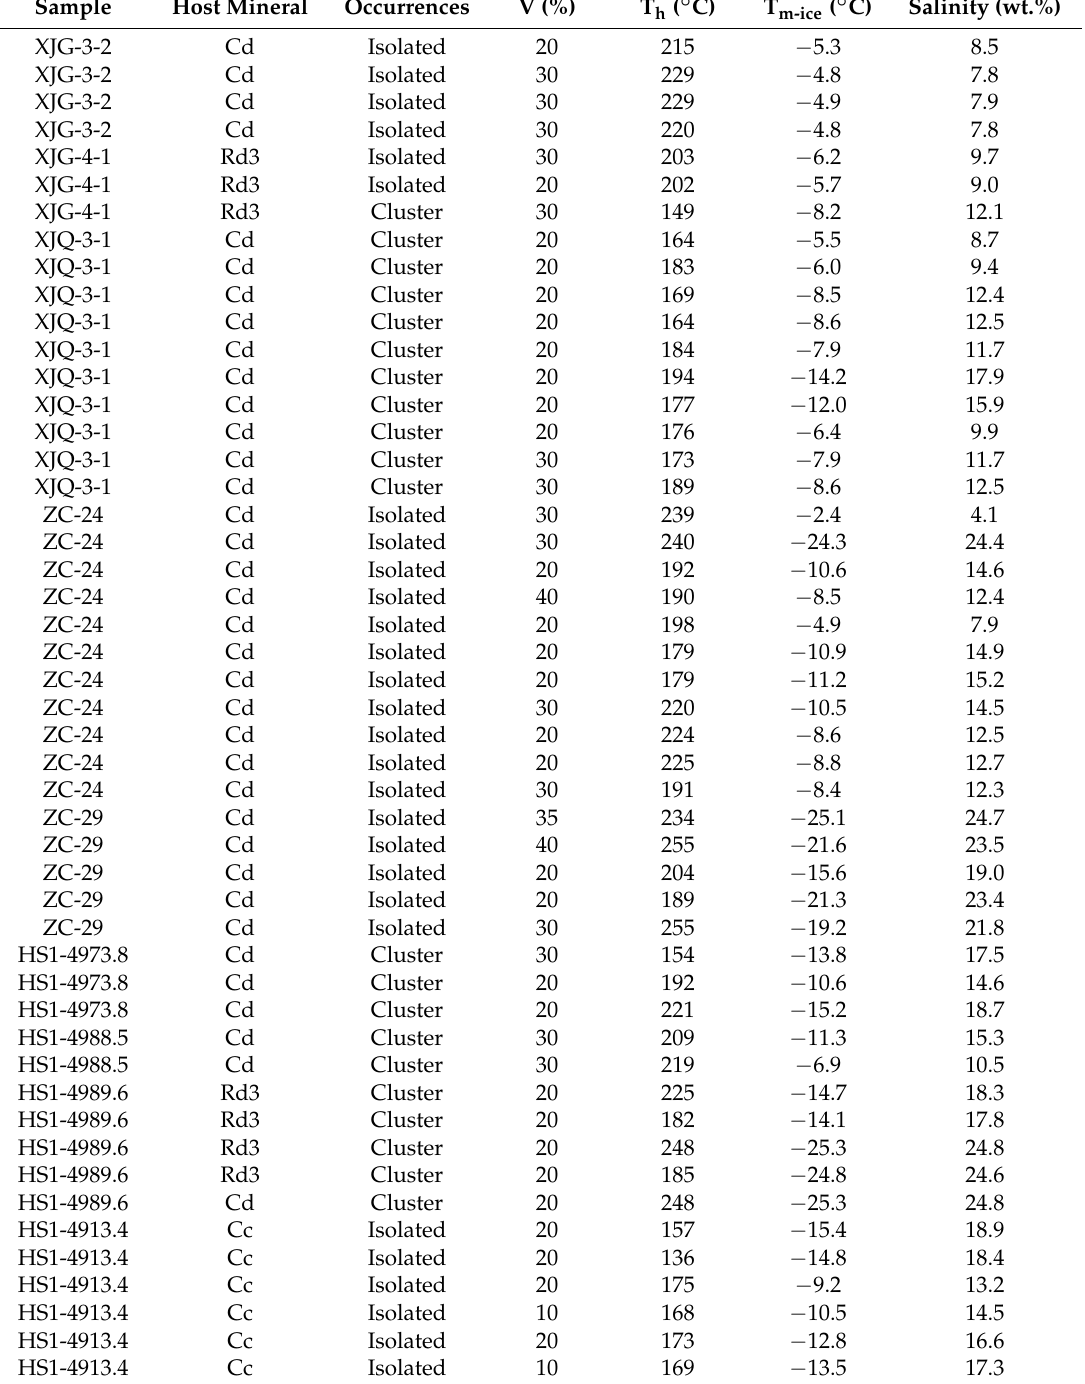
Table 1. Fluid inclusion data of Rd3 and Cd dolomite in Middle Permian in southwest (SW) Sichuan Basin. T h —homogenization temperature; T m-ice —ice melting temperature; XJG—Xinjigu